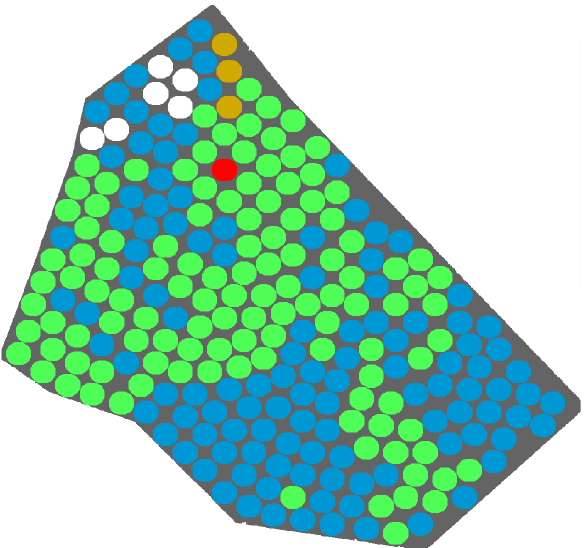
Figure 19: Densities of fuel types in circular areas with 10m radius of elevated